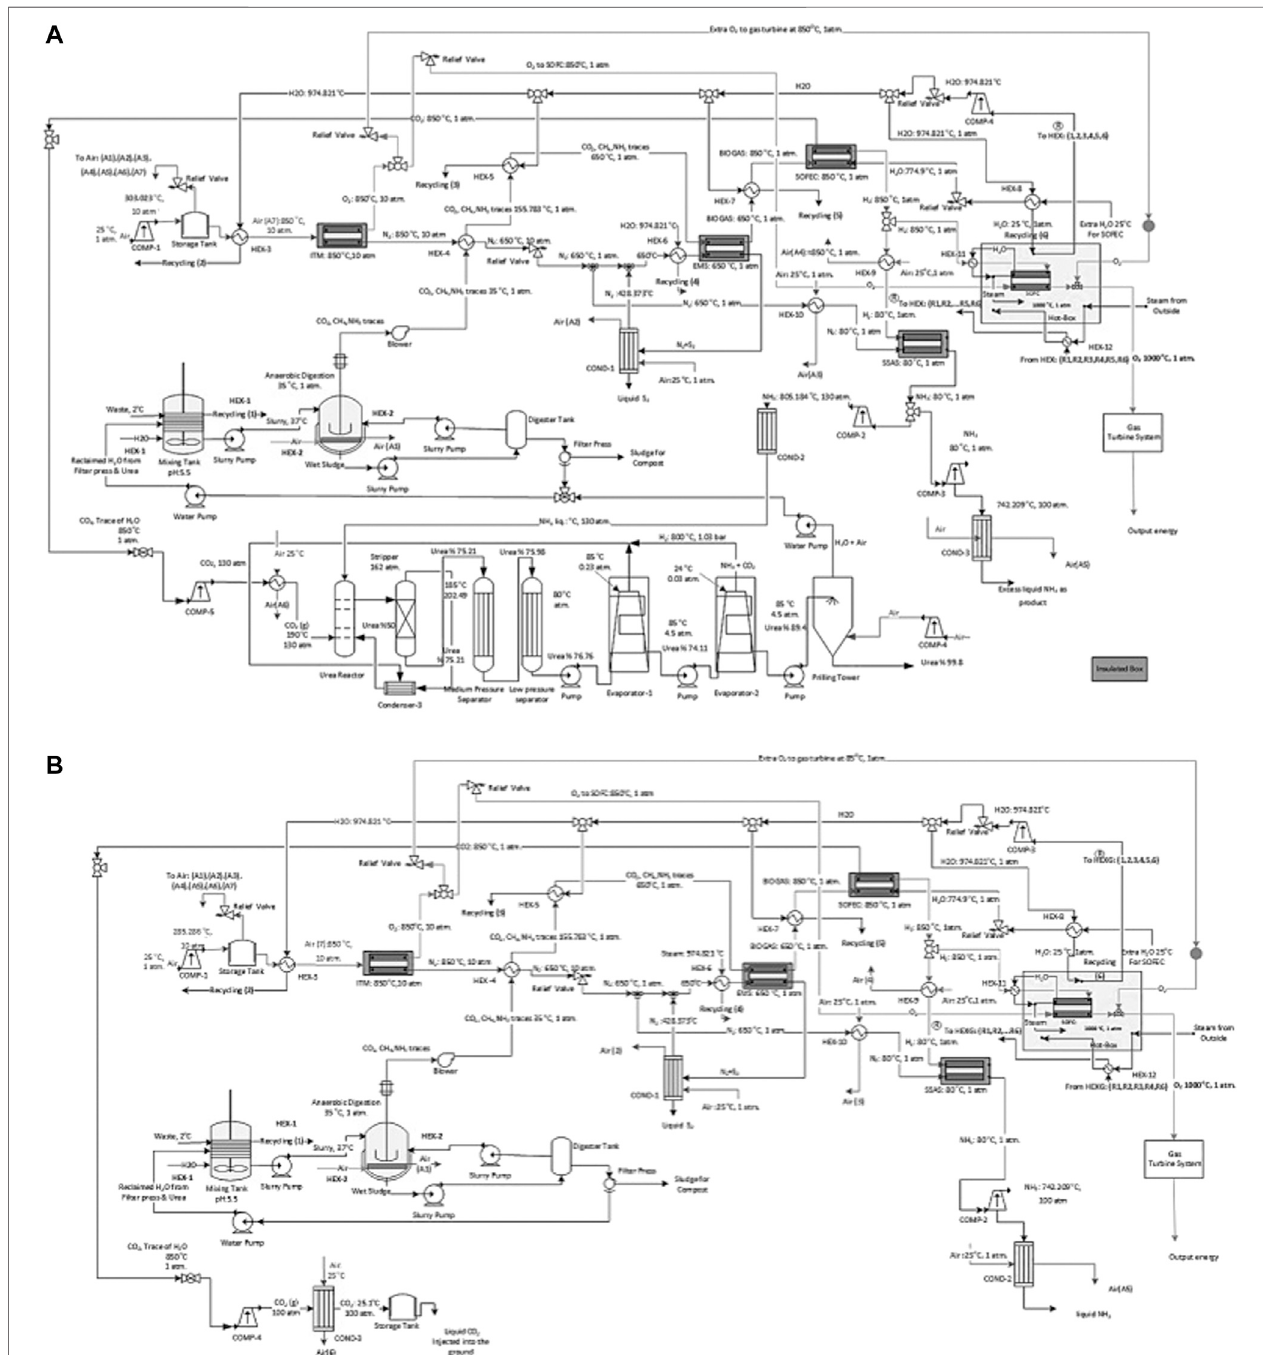
FIGURE 7 | A schematic of the process fl ow diagram of the proposed ammonia production process through, (A) AD with urea production and by incorporating SOFC and (B) AD without urea production with CCS and by incorporating SOFC.